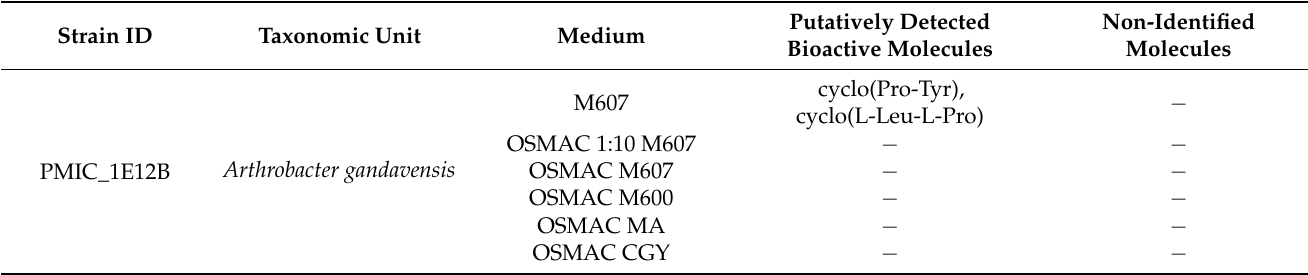
Table 3. Putatively identified bioactive compounds and non-identified molecules present in the